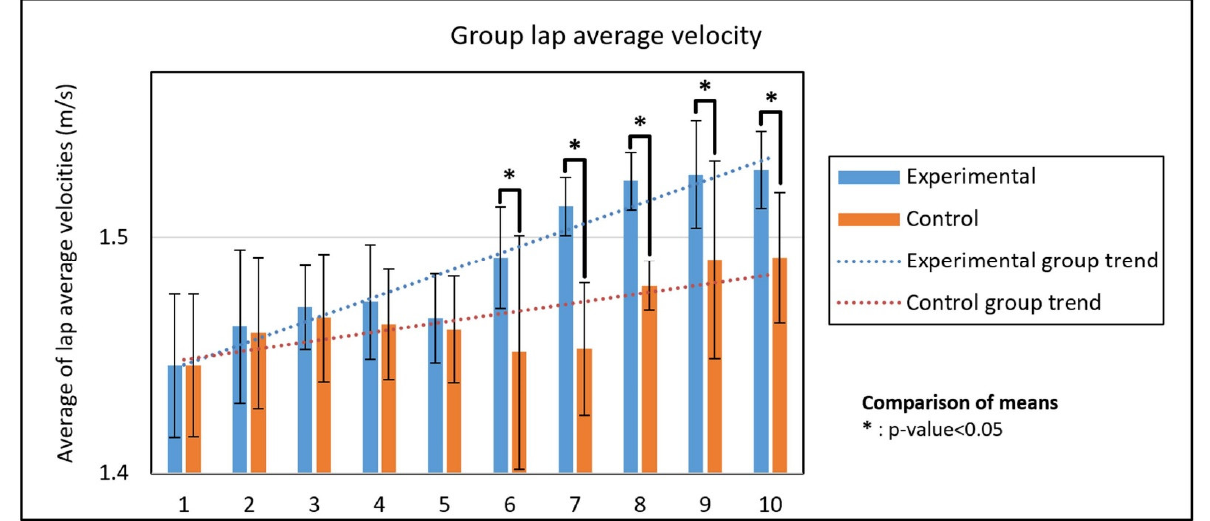
Figure A3. Average and standard deviation of lap average velocity goal metric for the experimental and control groups during ten test sessions.